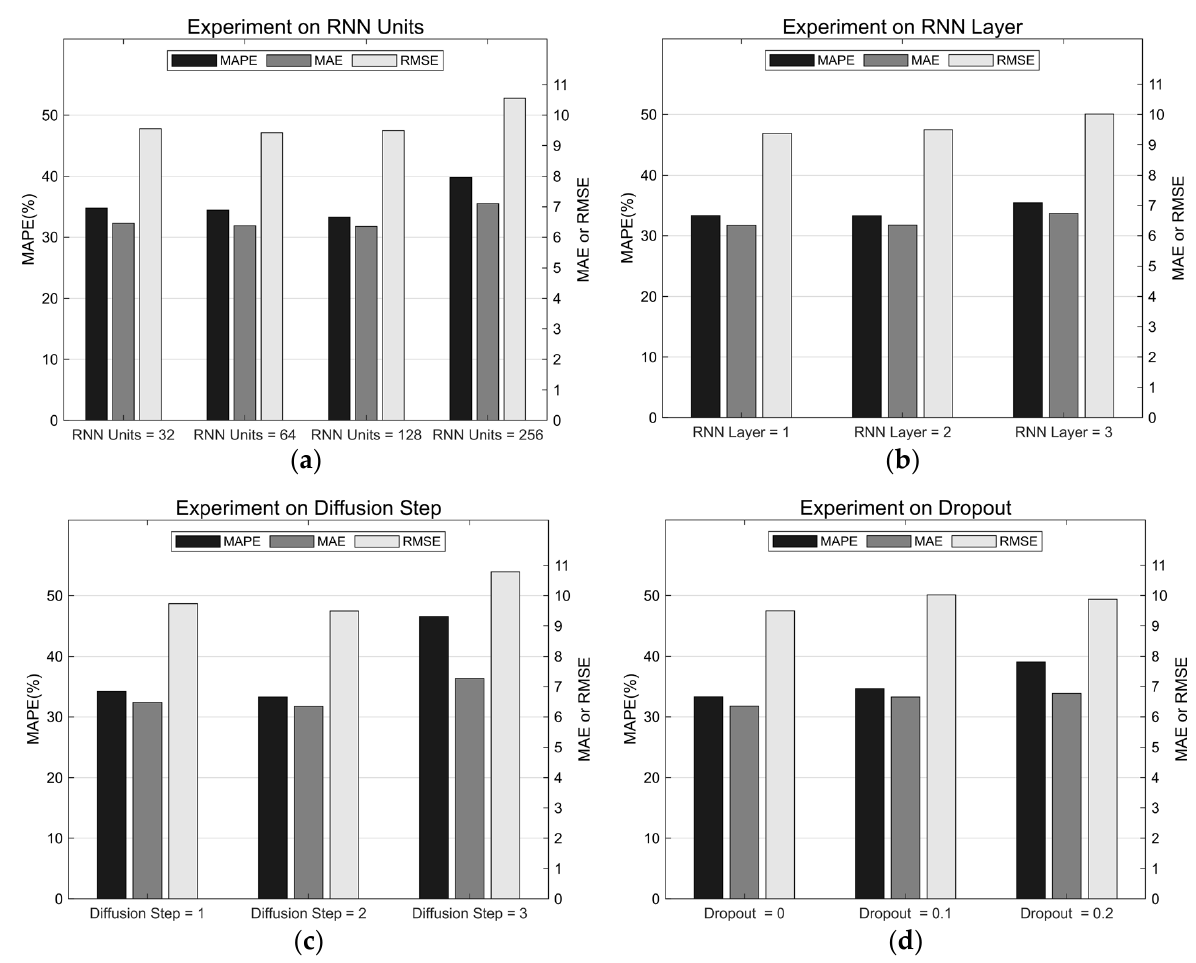
Figure 6. Comparison of the effect of each set of experiments on the model accuracy: ( a ) The impact of the number of hidden units; ( b ) The impact of the number of layers; ( c ) The impact of the diffusion steps; ( d ) The impact of dropout parameter.